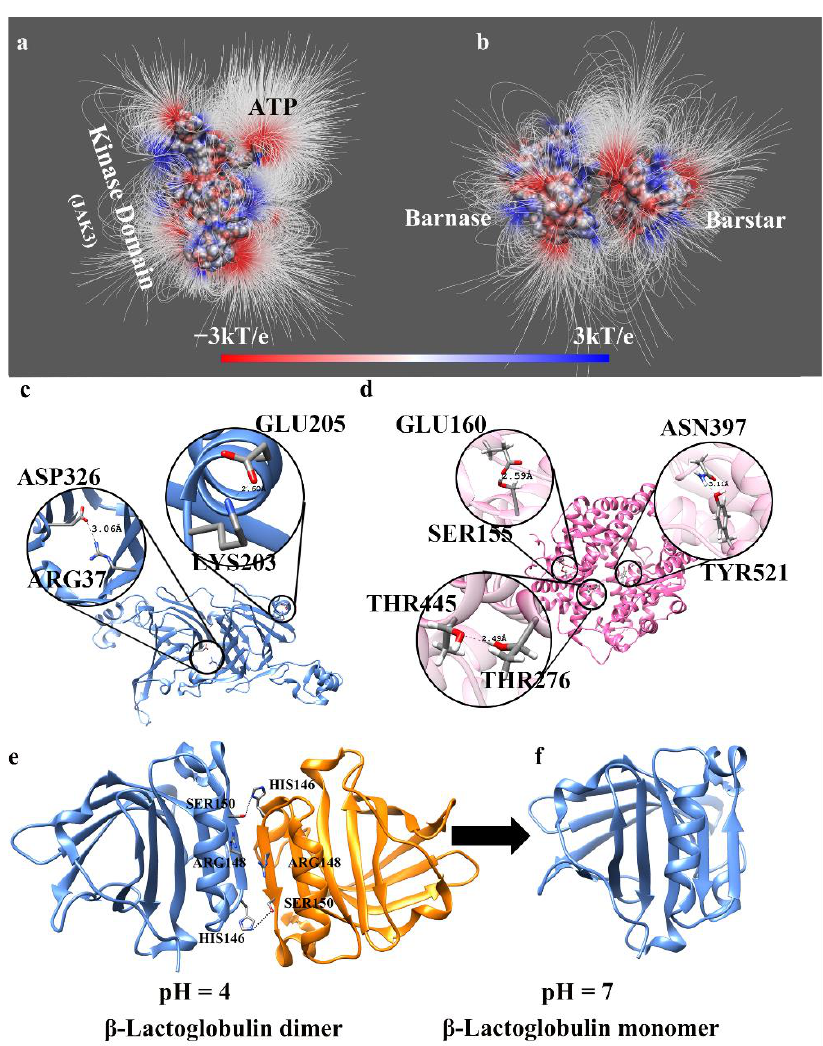
Figure 1. ( a ) The electric field lines between the JAK3 kinase domain and ATP. The kinase domain and ATP were separated by 15 Å to show the interactions [40] (the structure is constructed by I- TASSER [41] to model the missing loops). ( b ) The electric field lines between barnase and barstar (PDB: 1BRS [42]). The two proteins were separated by 10 Å to show the interactions. ( c ) The salt bridges in 8S α -Globulin (PDB: 2CV6 [43]). The missing loops of the 8S α -Globulin are modeled by